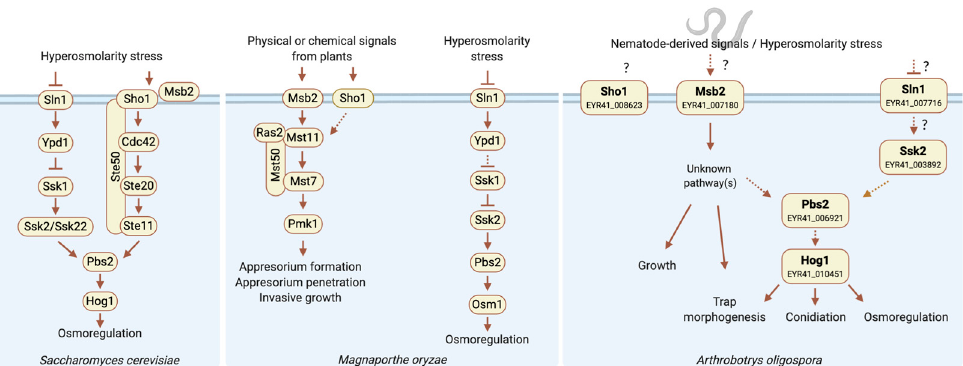
Figure 5. Schematic models for the role of Hog1 and Msb2 in yeast and filamentous fungi . S. cerevisiae Sln1, Sho1, and Msb2 sense the changes in the osmolarity of the extracellular environment and activate Hog1 for osmoregulation. The proteins separated by a slash symbol (/) are functionally redundant. Not all of the known components are shown. In blast fungus, M. oryzae , Msb2 and Sho1 are involved in recognizing physical or chemical signals from plant to activate the downstream Mst11-Mst7-Pmk1 MAPK cascade which is responsible for pathogenesis. The Ssk2-Pbs2-Osm1 MAPK cascade is activated by Sln1 to respond to changes in the osmolarity of the extracellular environment. In A. oligospora , both Hog1 and Msb2 are not only involved in osmoadaptation but also in growth, trap morphogenesis and conidiation. Solid and dashed arrows indicate the verified and putative connections, respectively. The figure was created with BioRender.com.